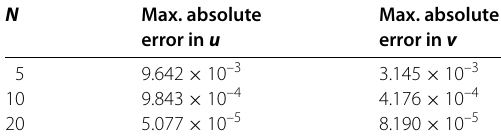
Table 1 Maximum absolute error for Example 1